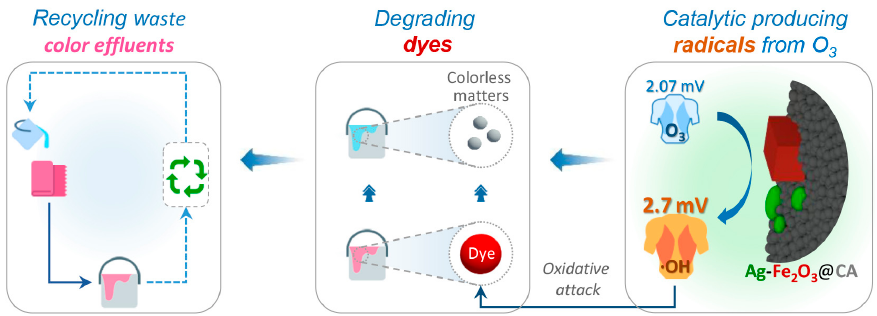
Figure 1. Ag–Fe 2 O 3 @CA facilitated catalytic ozonation for the recycling of waste rinsing effluents.